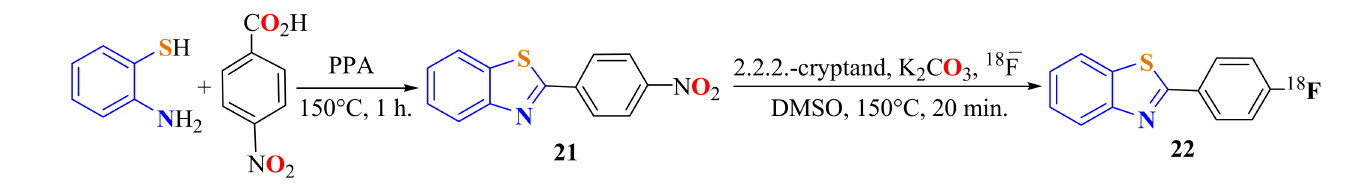
Scheme 11. Synthesis of 2-( p -nitrophenyl)benzothiazole to access 2-( p